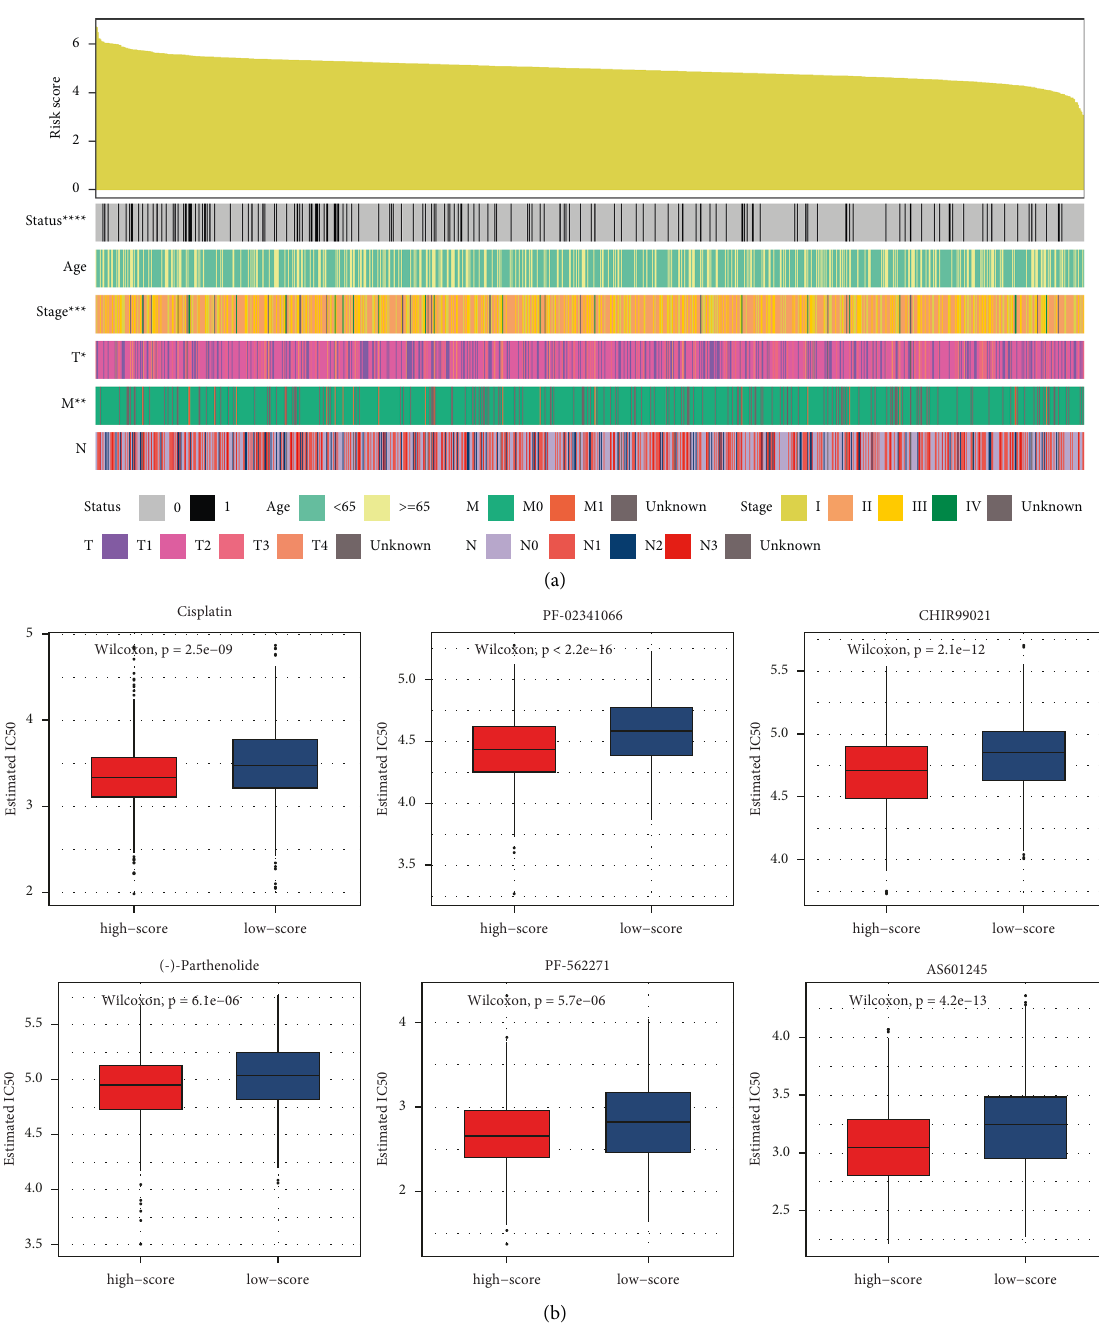
Figure 4: Clinical features and drug sensitivity prediction in breast cancer (BRCA) datasets. (a) Clinical characteristics of patients with BRCA, sorted by risk scores. (b) Predicted responses to drugs that might be used to treat